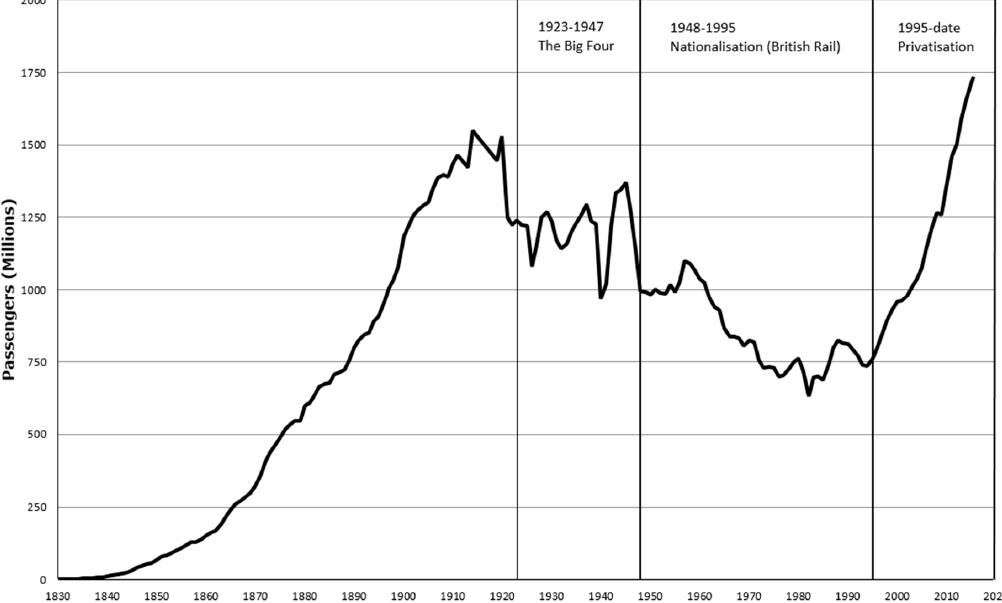
Figure 2. Railway passenger numbers in the U.K., 1829–2016. Source: Wikipedia Commons.